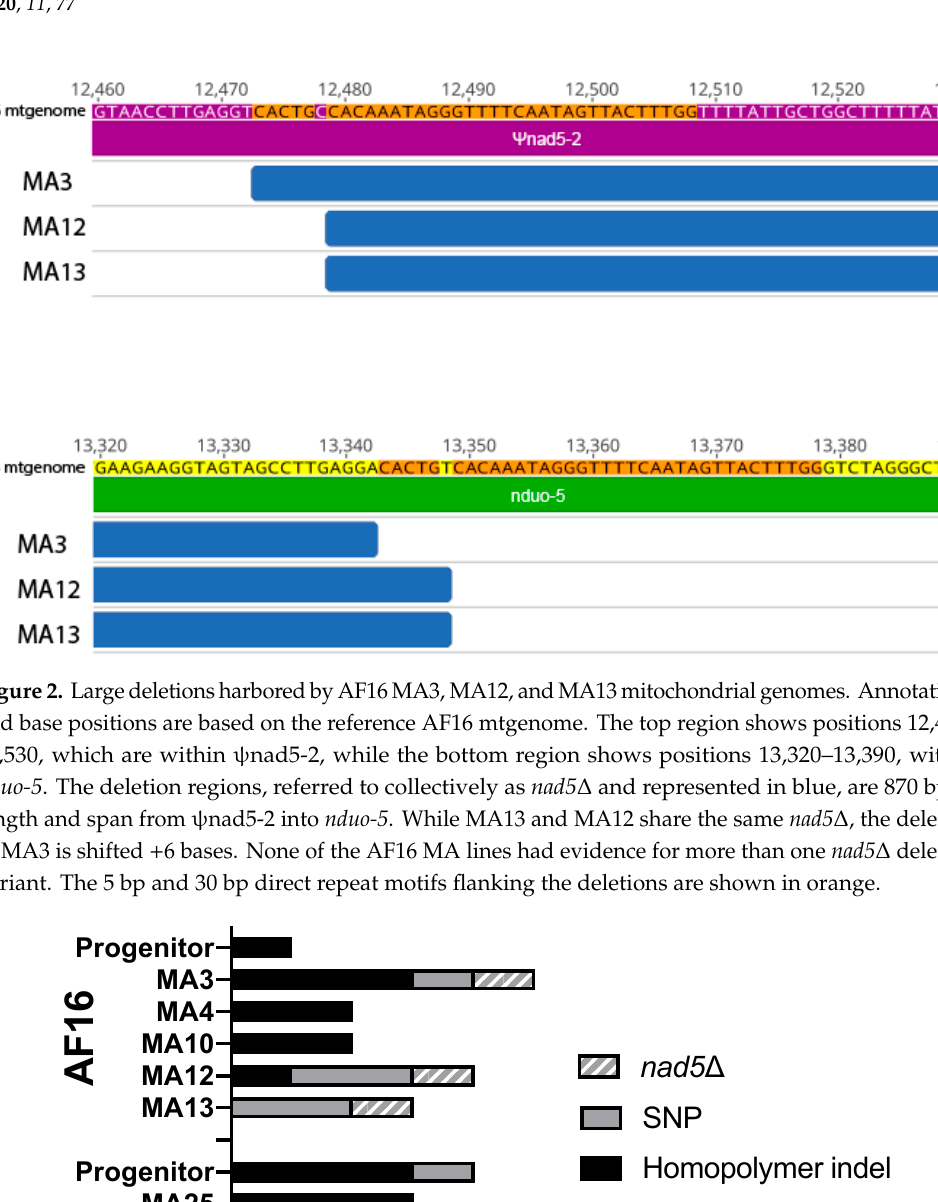
Figure 3. Total number of variant sites for each AF16 and ED3101 MA line and progenitor. The lined bars designate MA lines that also harbored an 870 bp deletion occurring between ψ nad5-2 and nduo- 5 .